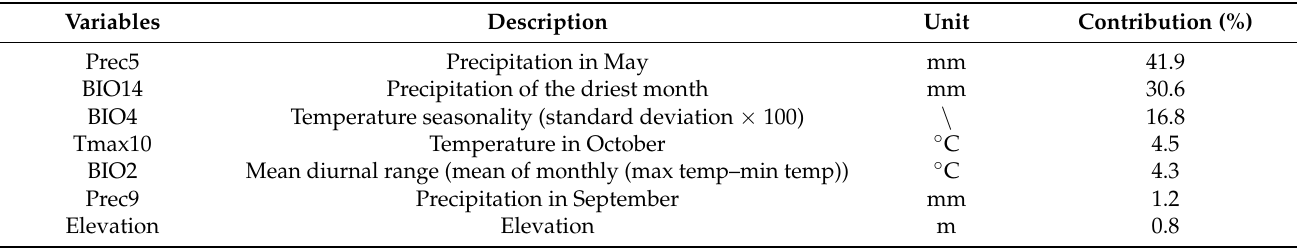
Table 1. Environmental variables used for predicting the potential geographic distribution of A. americanum .